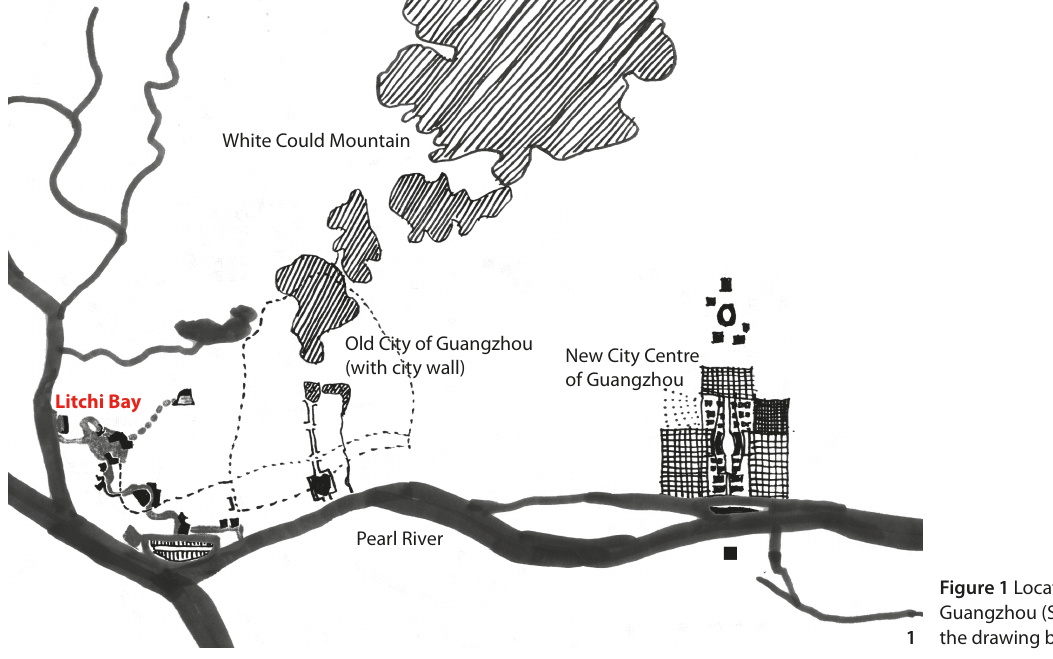
Figure 1 Location of Lichi Bay